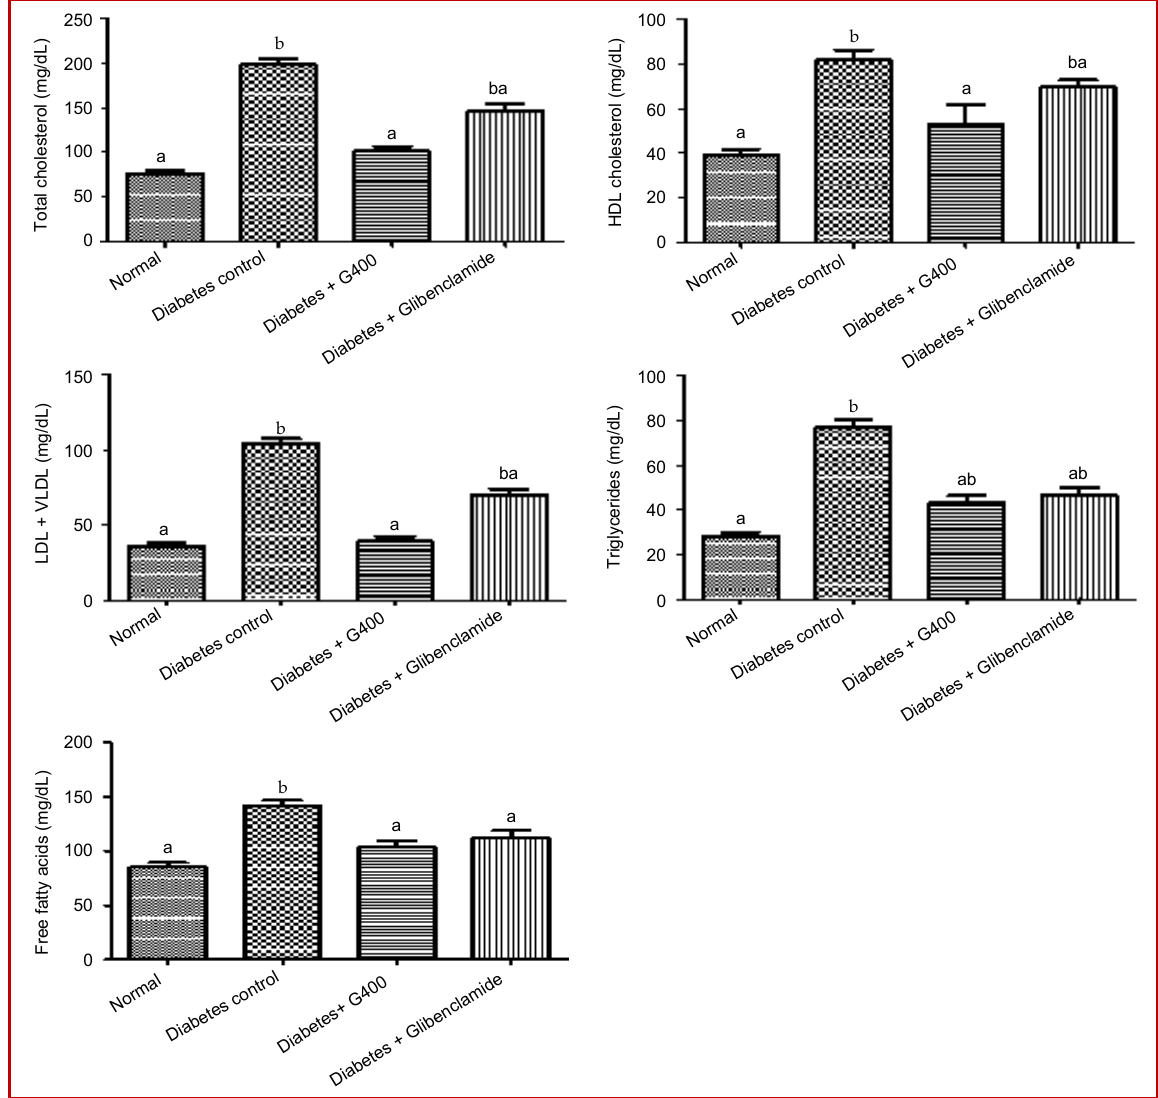
Figure 2: Effect of G-400 on the concentration of total cholesterol, HDL cholesterol, VLDL + LDL cholesterol, triglycerides and free fatty acids in blood samples Streptozotocin- treated diabetic rats were treated with G-400 (100 mg/kg b.wt.) daily using an intragastric tube for 4 weeks. The results were compared with diabetic control rats (group 2) and normal control (group 1), where no streptozotocin was